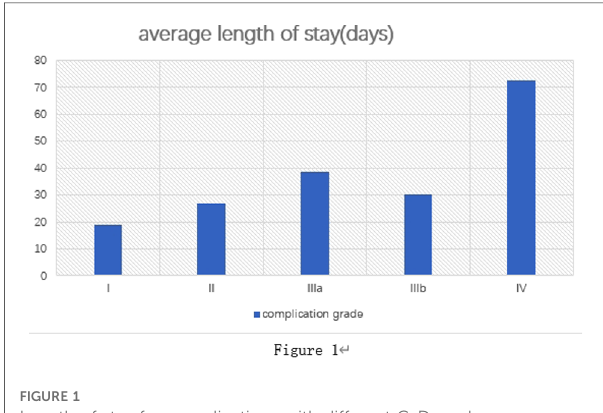
FIGURE 1 Length of stay for complications with different C-D